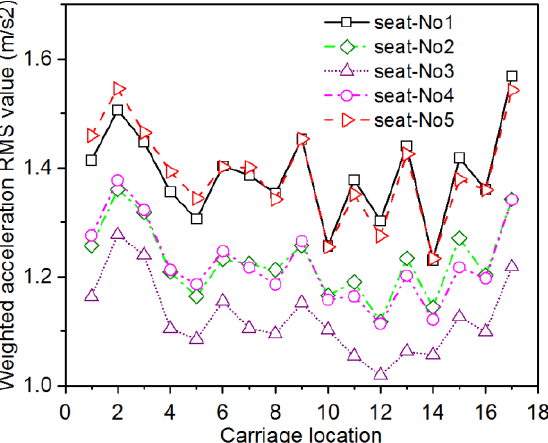
Figure 13. The distribution of the values of ride comfort parameter N VA in the carriage.